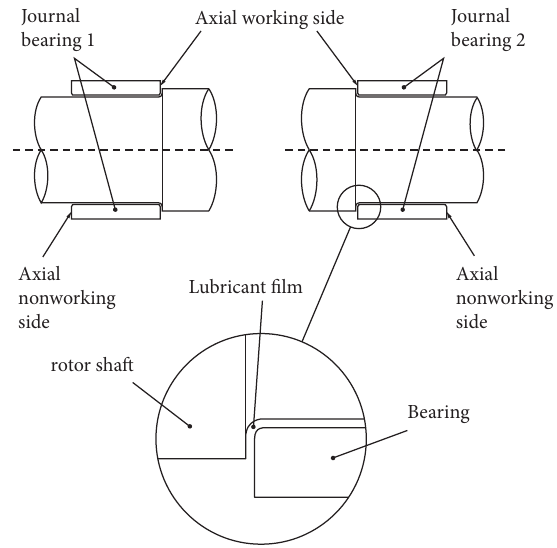
Figure 13: Axial working and nonworking side of two bearings.